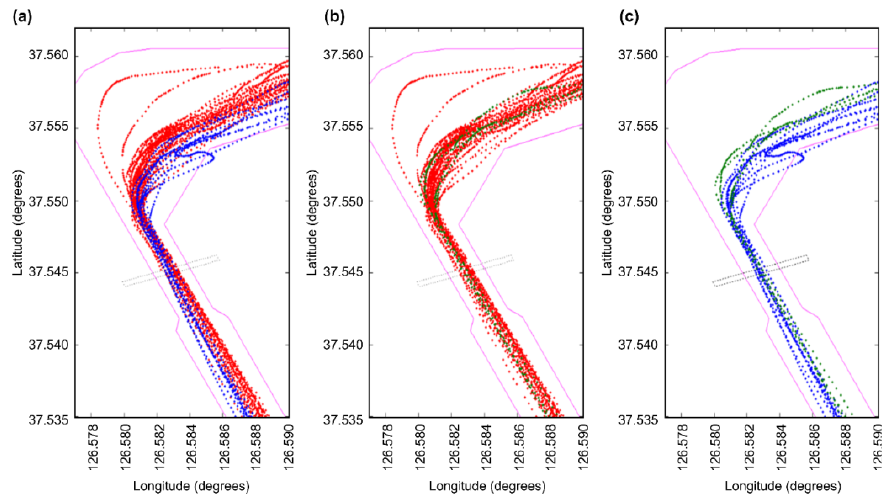
Figure 7. Track comparisons according to the tide situation: ( a ) flood current vs. ebb current; ( b ) flood current vs. near slack; ( c ) near slack vs. ebb